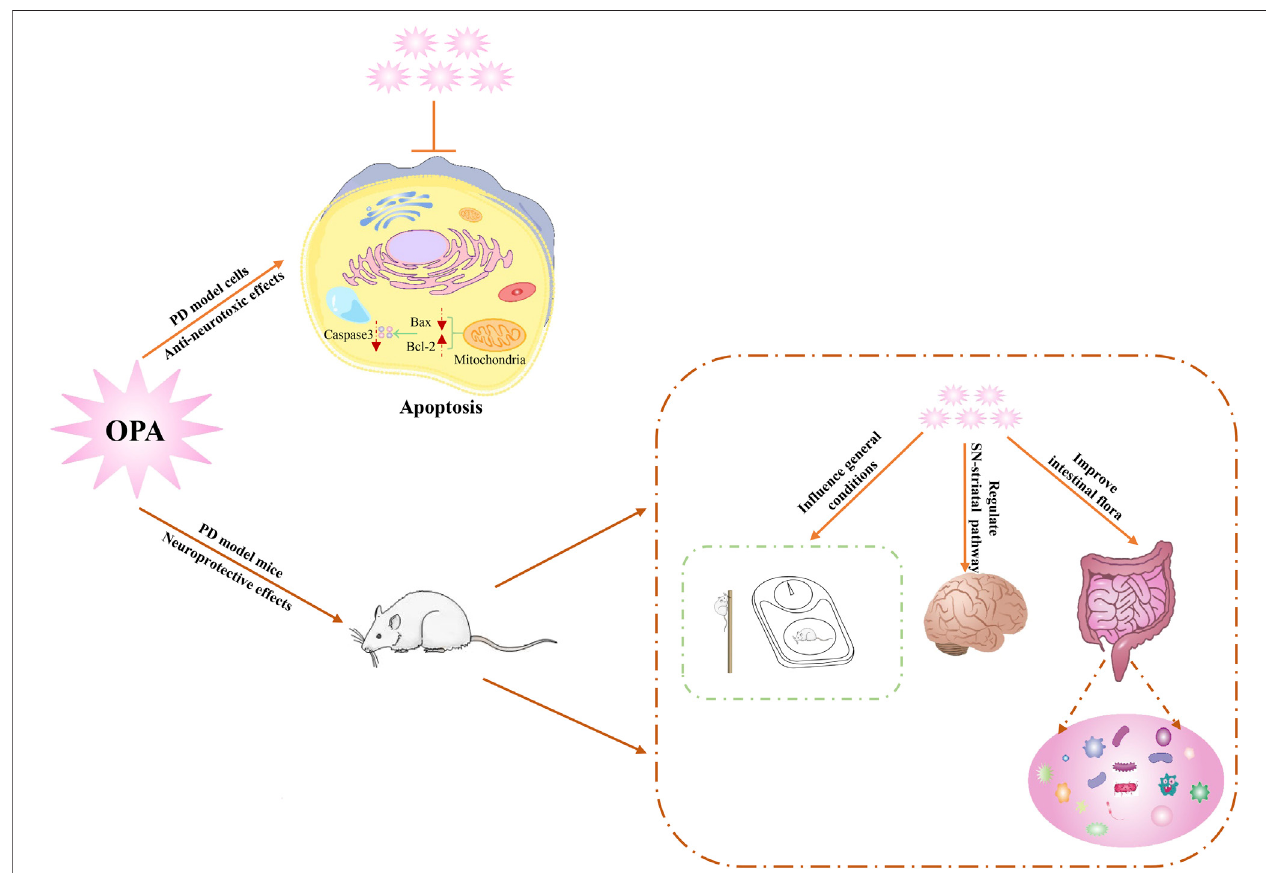
FIGURE 6 | Schematic diagram of underlying mechanism for neuroprotective effects of OPA on PD models.